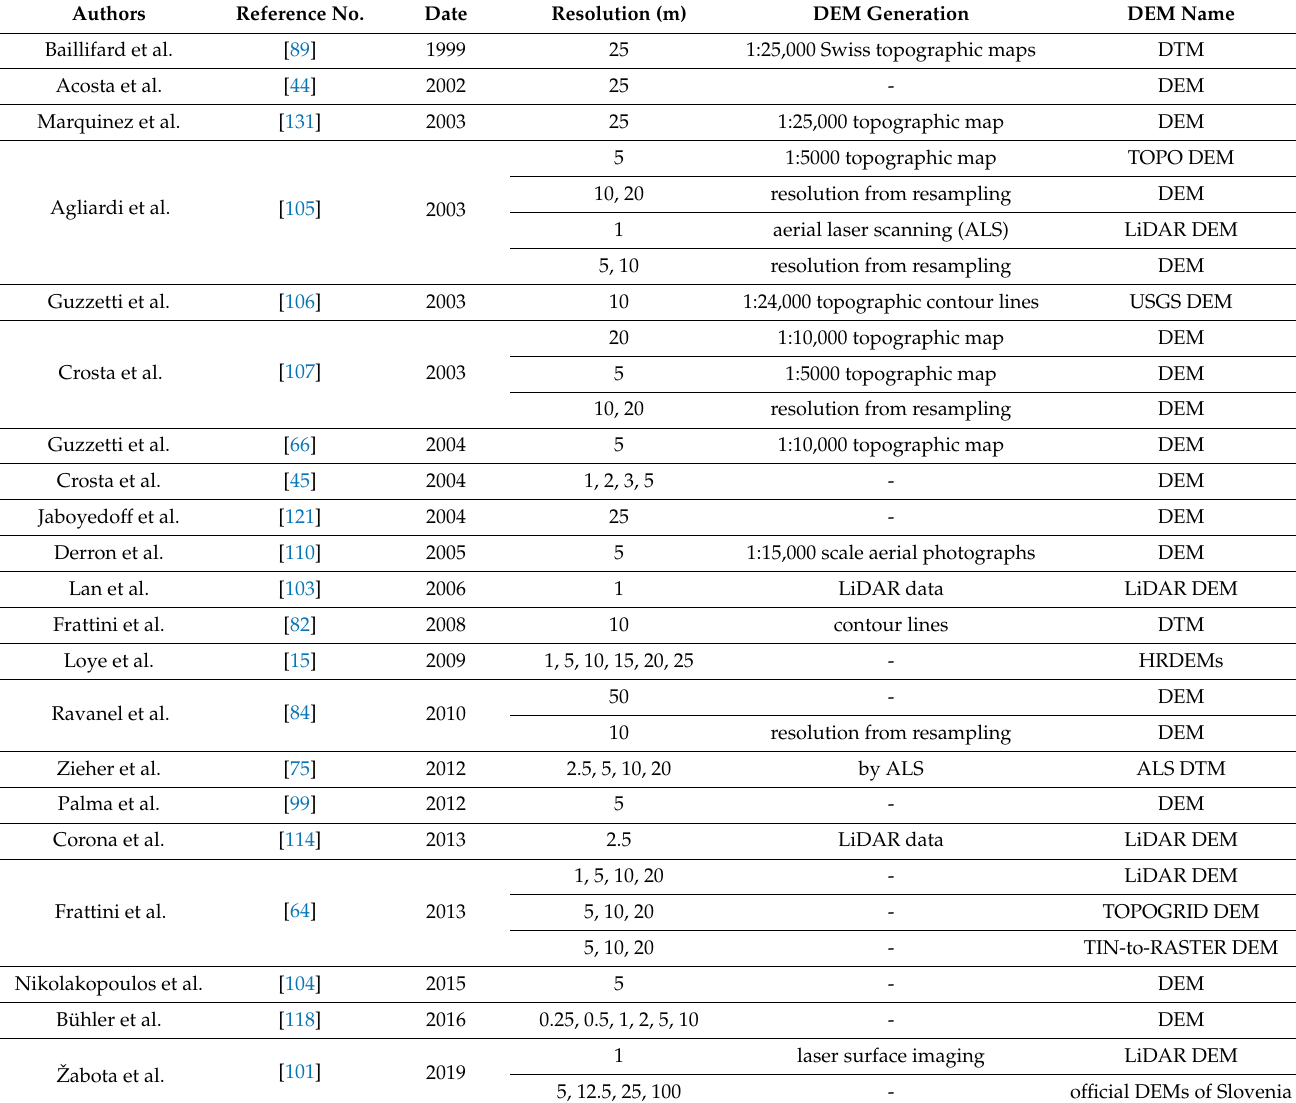
Table 2. Resolutions used for rockfall